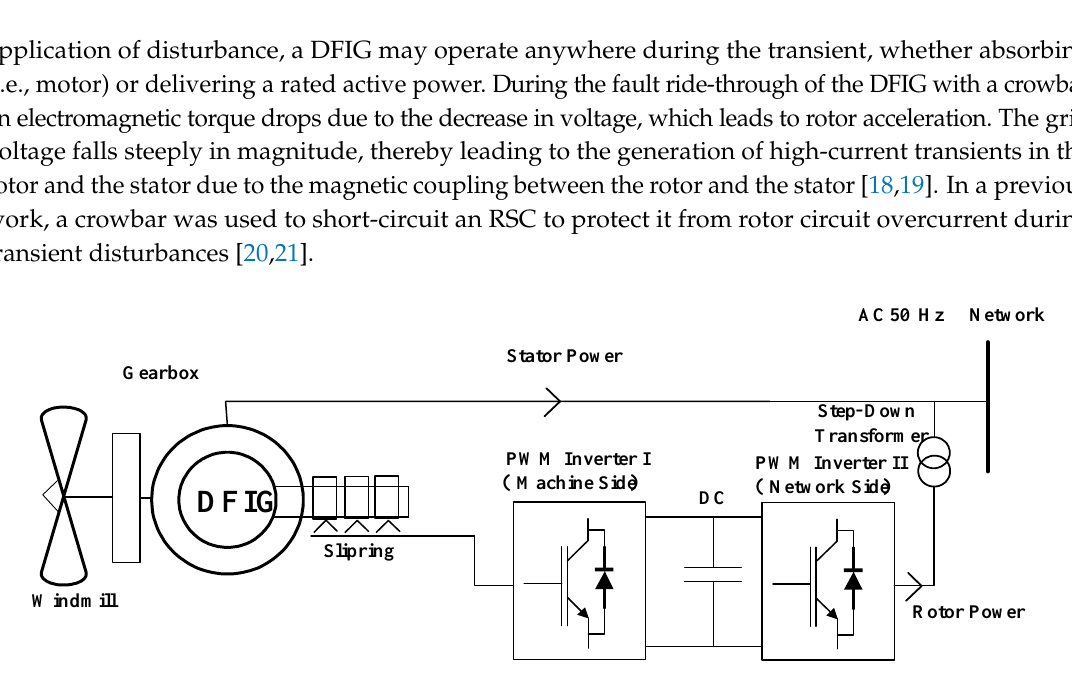
Figure 1. DFIG-equipped wind turbine.